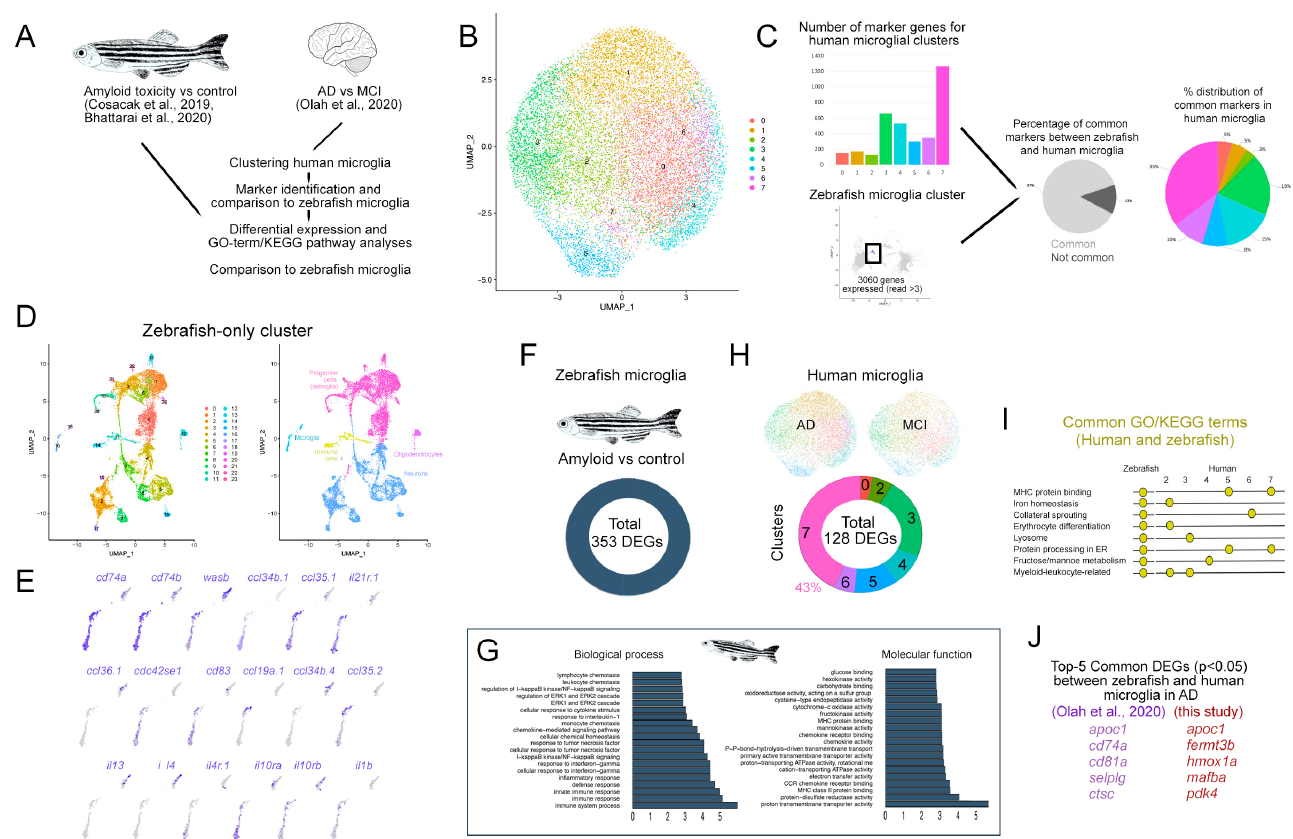
Figure 6. Comparison of human and zebrafish microglia. ( A ) Schematic representation of the analysis pipeline. Open access datasets from [38,40,41] ( B ) Clustering of the human microglia single cell sequencing data. ( C ) Comparison of the number of marker genes in microglial clusters, pie charts for the percentage of common marker genes of zebrafish microglia and human microglia, and the distribution of the common genes to individual human microglial clusters. ( D ) Clustering of zebrafish single cell sequencing dataset, both alone and color-coded tSNE plots for cell types. ( E ) Zebrafish immune cell clusters and representative gene expressions. ( F ) Differentially expressed gene analyses in zebrafish microglia and human microglia in AD. ( G ) Representative graphs of the biological process and molecular functions of the differentially expressed genes in zebrafish microglia in the AD model. ( H ) Clustering of human microglia dataset [38] from Alzheimer’s disease versus Mild cognitive impairment patients and differentially expressed gene numbers. ( I ) Representative GO terms and KEGG pathways that are common in human and zebrafish microglia. ( J ) Comparison of the top five common differentially expressed genes in zebrafish [40,41] and human microglia [38] in AD. See Datas